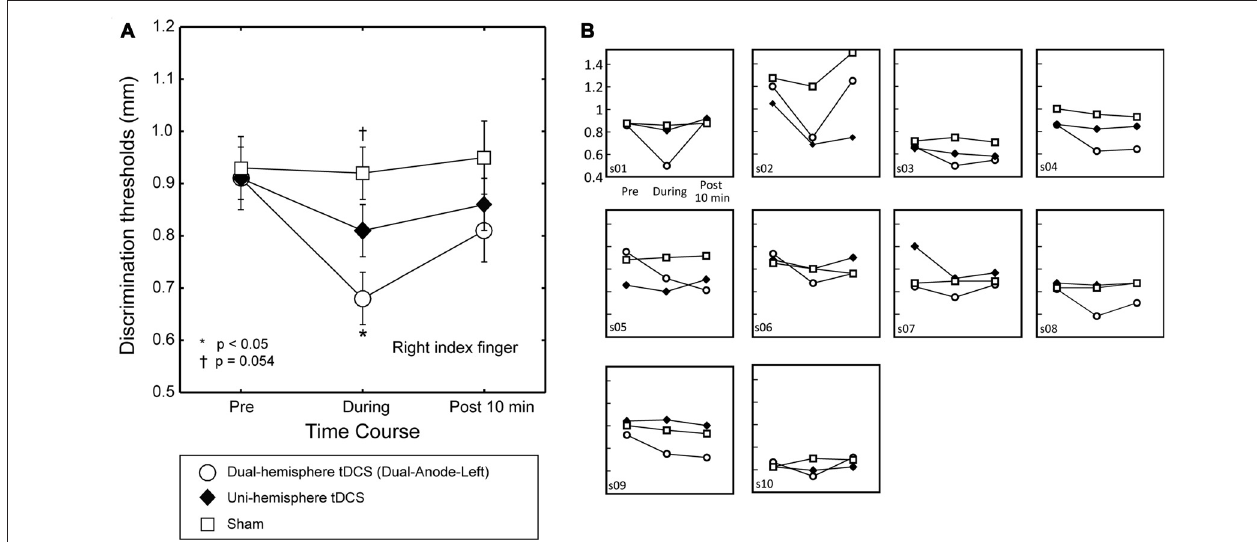
FIGURE 2 | The effect of dual-hemisphere vs. uni-hemisphere tDCS on grating orientation threshold. The mean grating orientation threshold of the right finger in each intervention is plotted as a time course with bars indicating the SEM. (A) Asterisks indicate significant differences in the threshold relative to uni-hemisphere tDCS. Compared with uni-hemisphere tDCS, Dual-Anode-Left tDCS (white circle) elicited a significantly lower threshold during the stimulation (During). There was a trend towards a significant difference between the uni-hemisphere tDCS and sham conditions during the stimulation. (B) Results of each individual participant.